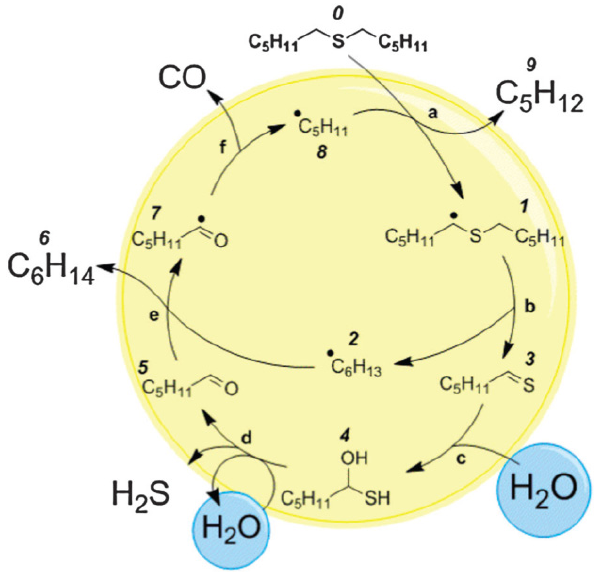
Figure 7. Reaction pathway of hexyl sulfide in SCW. Reproduced with permission from [75], published by The Royal Society of Chemistry,